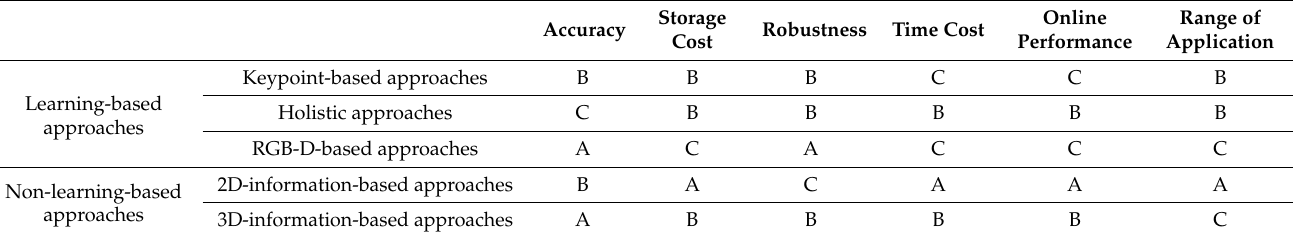
Table 1. Comparison of three kinds of